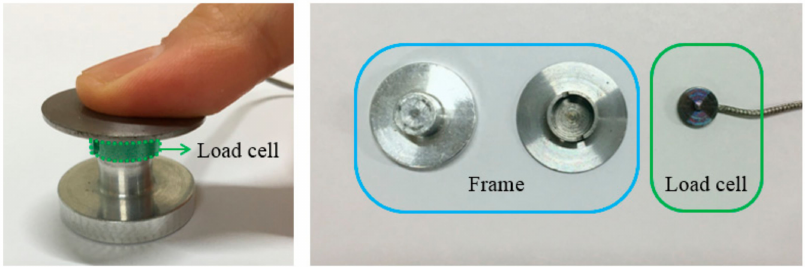
Figure 1. Hardware of thumb force measurement